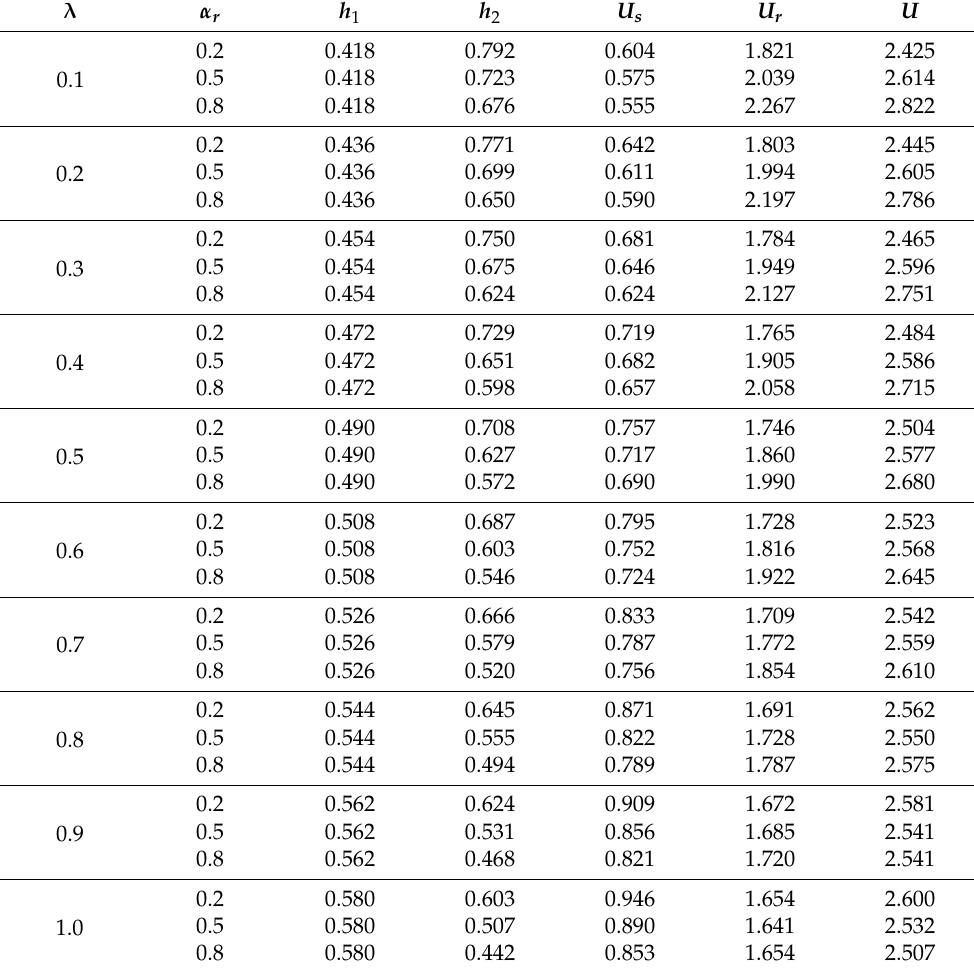
Table 1. The utility values of retailers, distributors, and supply chains under different distribution